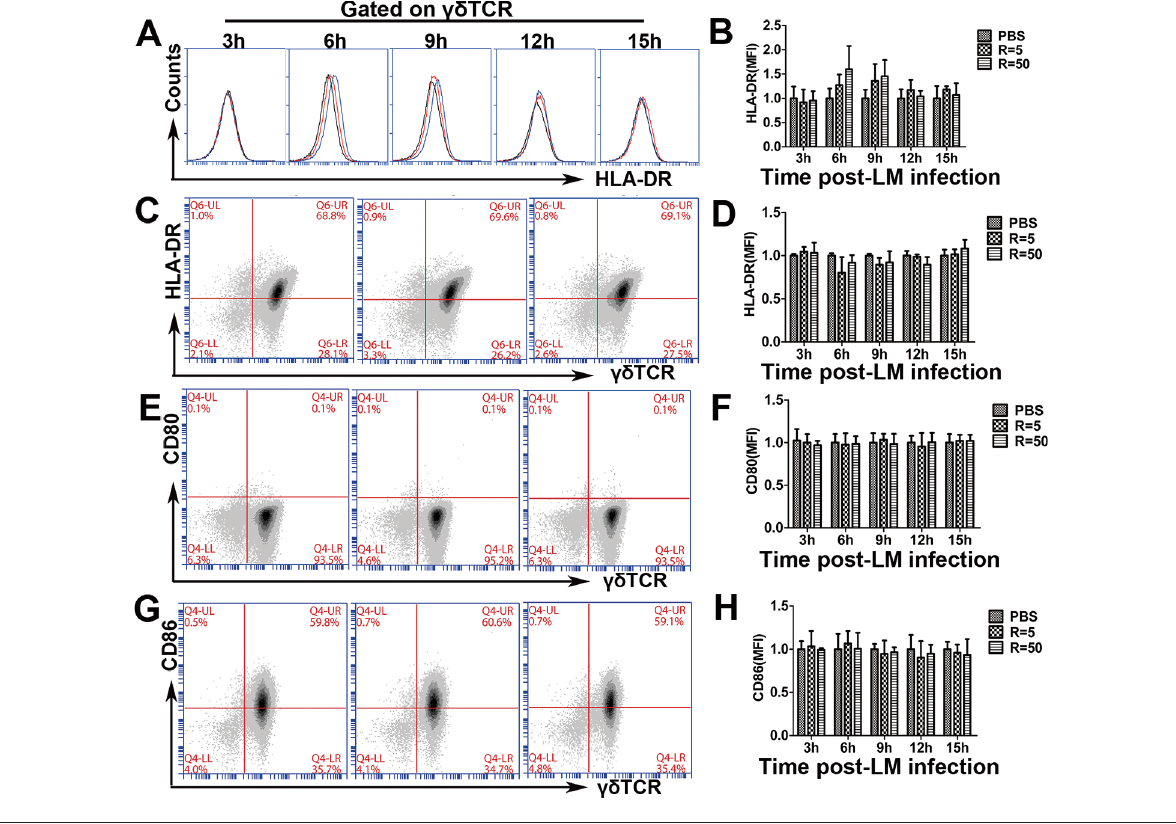
Figure 3. FCM analysis of antigen presentation related markers on γδ T cells in response to L. monocytogenes infection. (A) The level of HLA-DR expression increased on rested γδ T cells six hours after incubation with L. monocytogenes . (B) Quantification of normalized mean fluorescence intensities (MFI) of HLA-DR expression on rested γδ T cells in different groups. R represents the ratio of bacteria number to γδ T cell number. The high ratio of bacterium-to-cell of 50:1 (blue line) induced more HLA-DR expression on rested γδ T cells compared with low ratio (red line) or PBS (black line). No significant changes were observed at 12 h and15 h time points. (C, D, E, F, G and H) No signifi- cant change was observed in the expression level of HLA-DR (C and D), CD80 (E and F) or CD86 (G and H) on activated γδ T cells either in the presence or absence of L. monocytogenes . Data are shown as mean ± SEM (Independent experiments: n = 5).